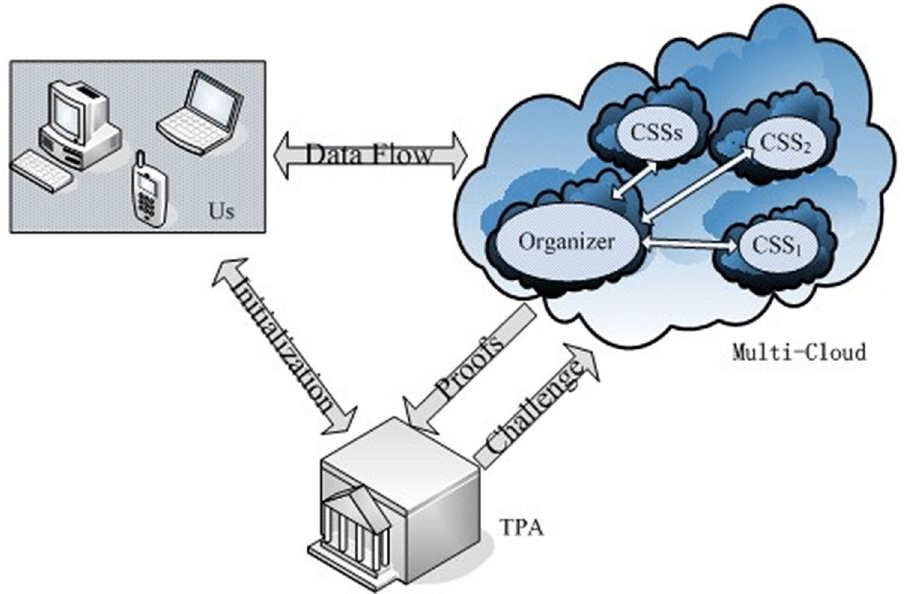
Figure 1. Multi-cloud